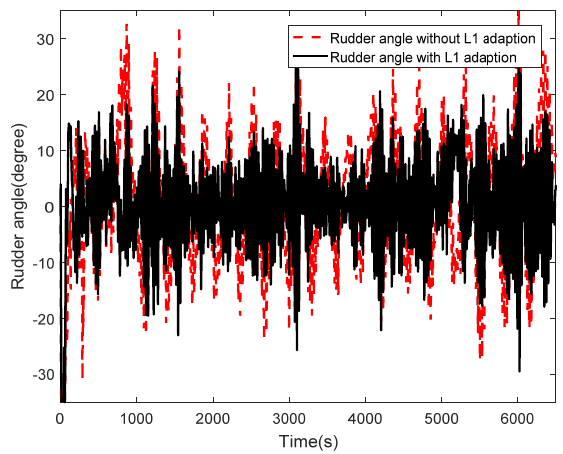
Figure 6. Rudder angles with and without the L 1 adaptive control.